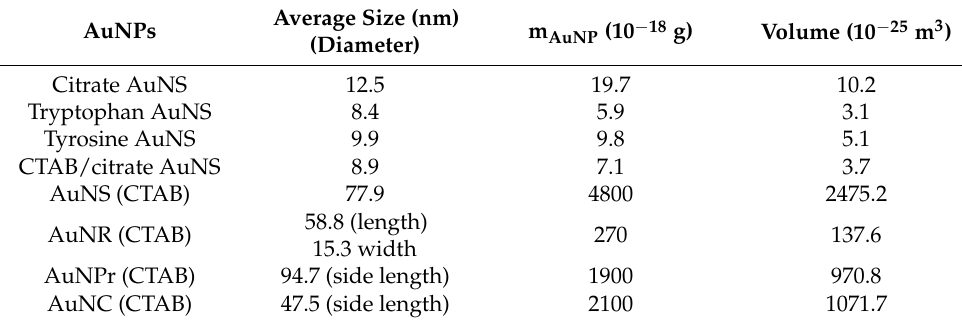
Table 2. AuNP dimension, weights, and